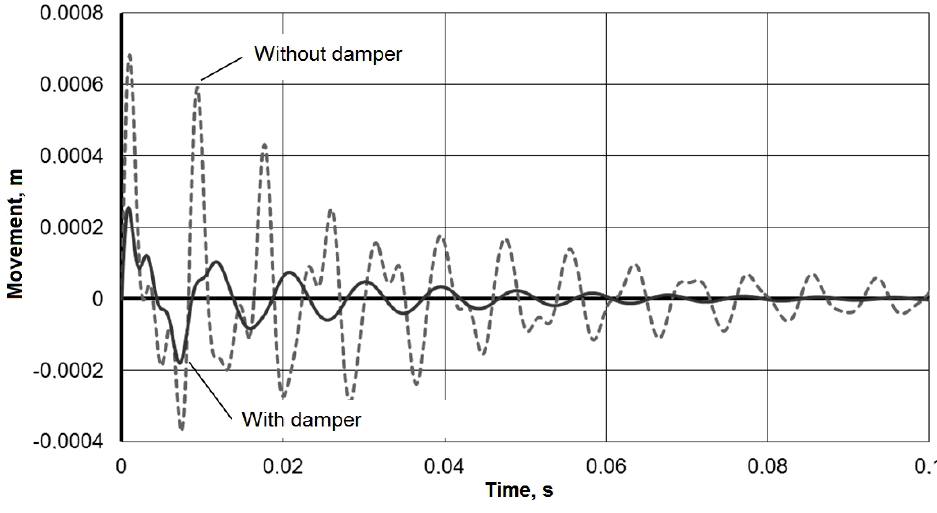
Figure 5. Impulse responses comparison.